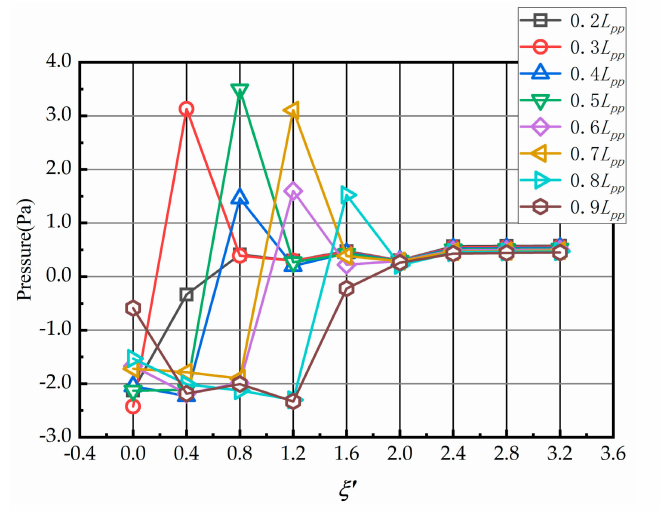
Figure 10. Variation in hydrodynamic pressure at different values of ξ (cid:48)